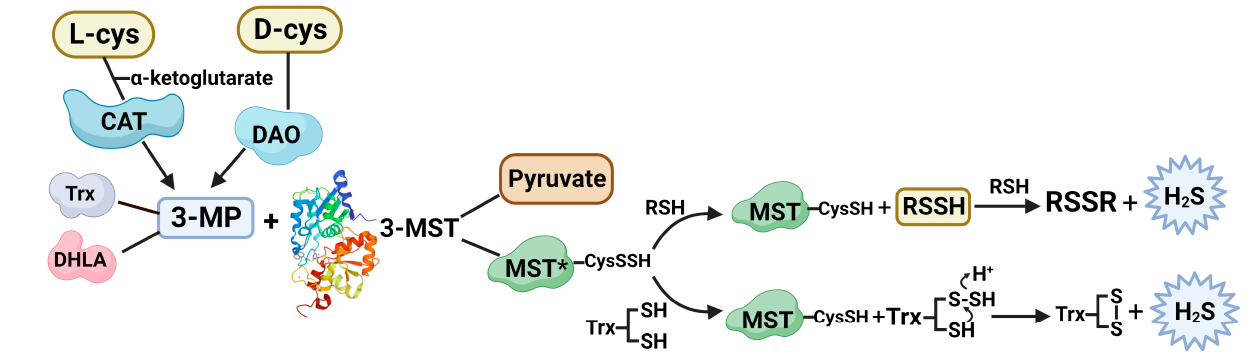
Figure 1. Physiological reaction of 3-mercaptopyruvate sulfurtransferase (3-MST) to produce H 2 S from substrate 3-mercaptopyruvate (3-MP) in the presence of endogenous cofactors thioredoxin (Trx) and dihydrolipoic acid (DHLA). 3-MP is generated from L-cysteine and D-cysteine by cysteine aminotransferase (CAT) and diamine oxidase (DAO), respectively. Reaction of 3-MP with 3-MST causes persulfidation of cysteine sulfhydryl, which sequentially reacts with thiol-containing substrates depicted as R-SH, resulting in the release of H2S. Similarly, reaction of reduced thioredoxin with persulfidated 3-MST yields oxidized Trx with release of H 2 S. Created with Biorender.com (accessed on 18 January